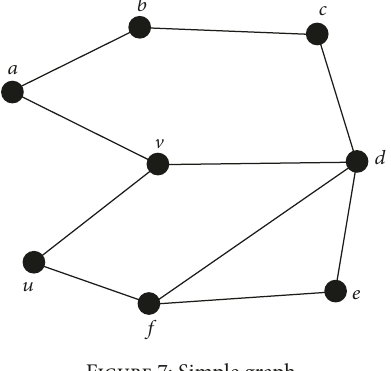
Figure 7: Simple